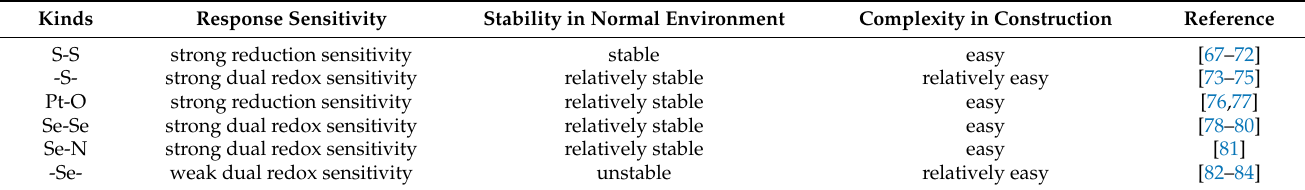
Table 1. Redox-sensitive chemical bonds and their